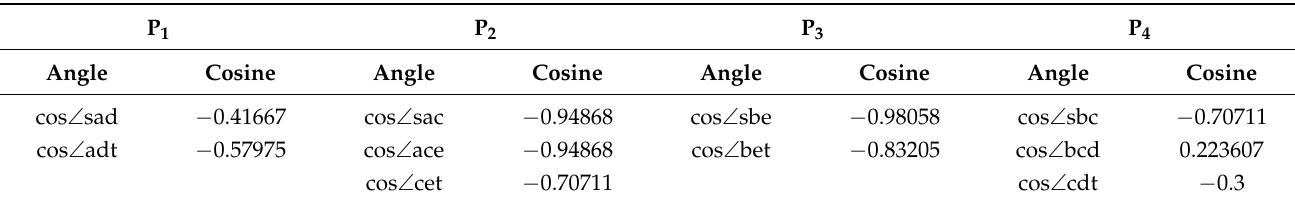
Table 4. Cosine values of angles.